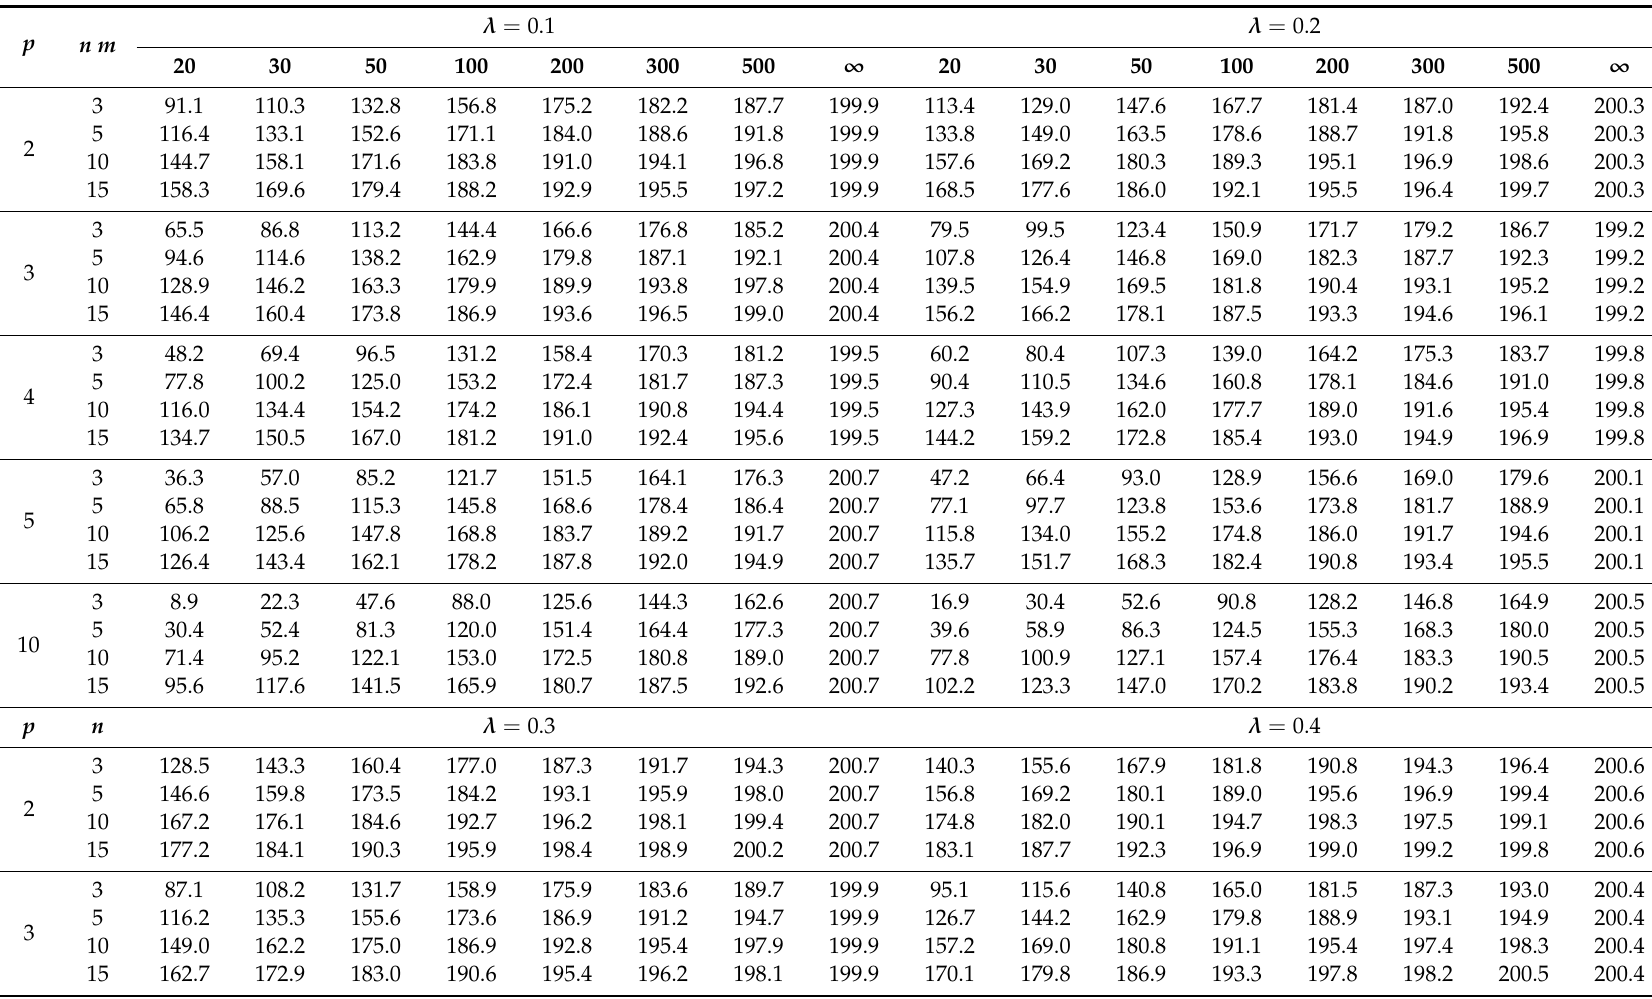
Table 5. Estimation e ff ect on ARL0